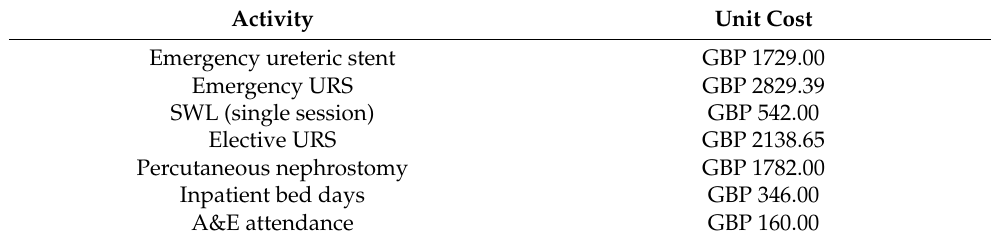
Table 3. Overall cost per procedure/visit.